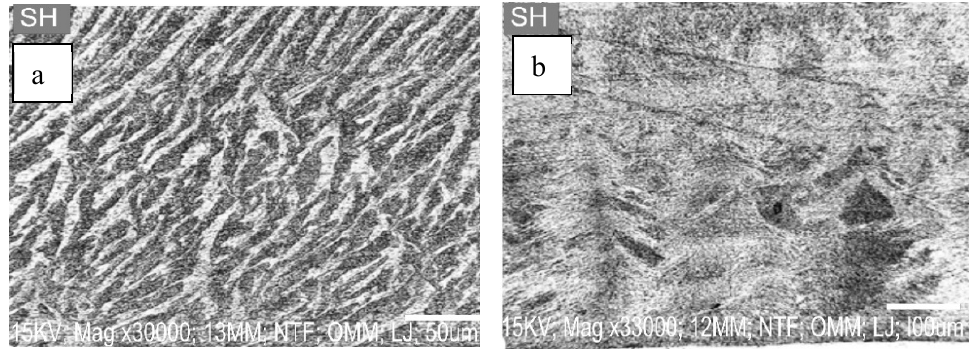
Figure 2. ( a , b ): The SEM images of SP .